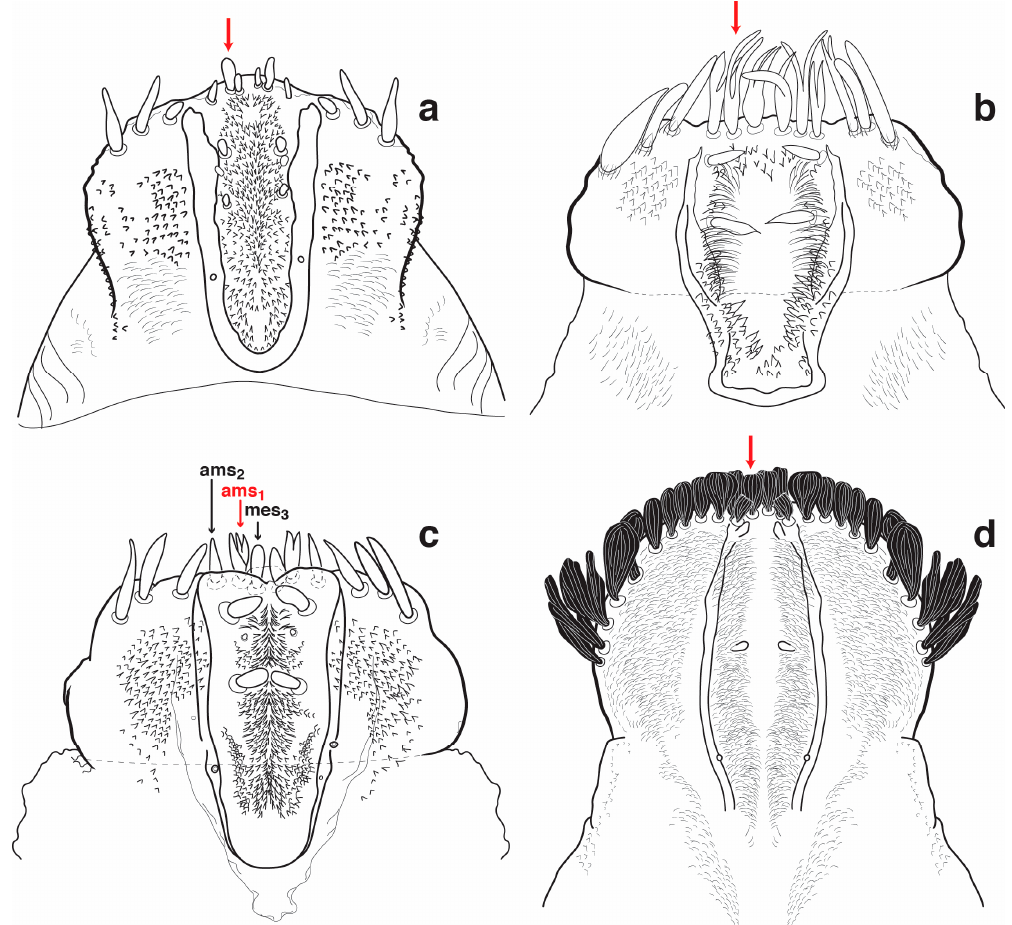
Figure 27. Epipharynx, larva: ( a ) Phacecorynes ; ( b ) Temnoschoita ; ( c ) Poteriophorus ; and ( d ) Rhinostomus. Mes3: median epipharyngeal setae; ams1, 2: anteromedian setae of epipharynx. 14. Shape of anteromedian epipharyngeal seta 2 (ams2) (Figure 28) a. Entire